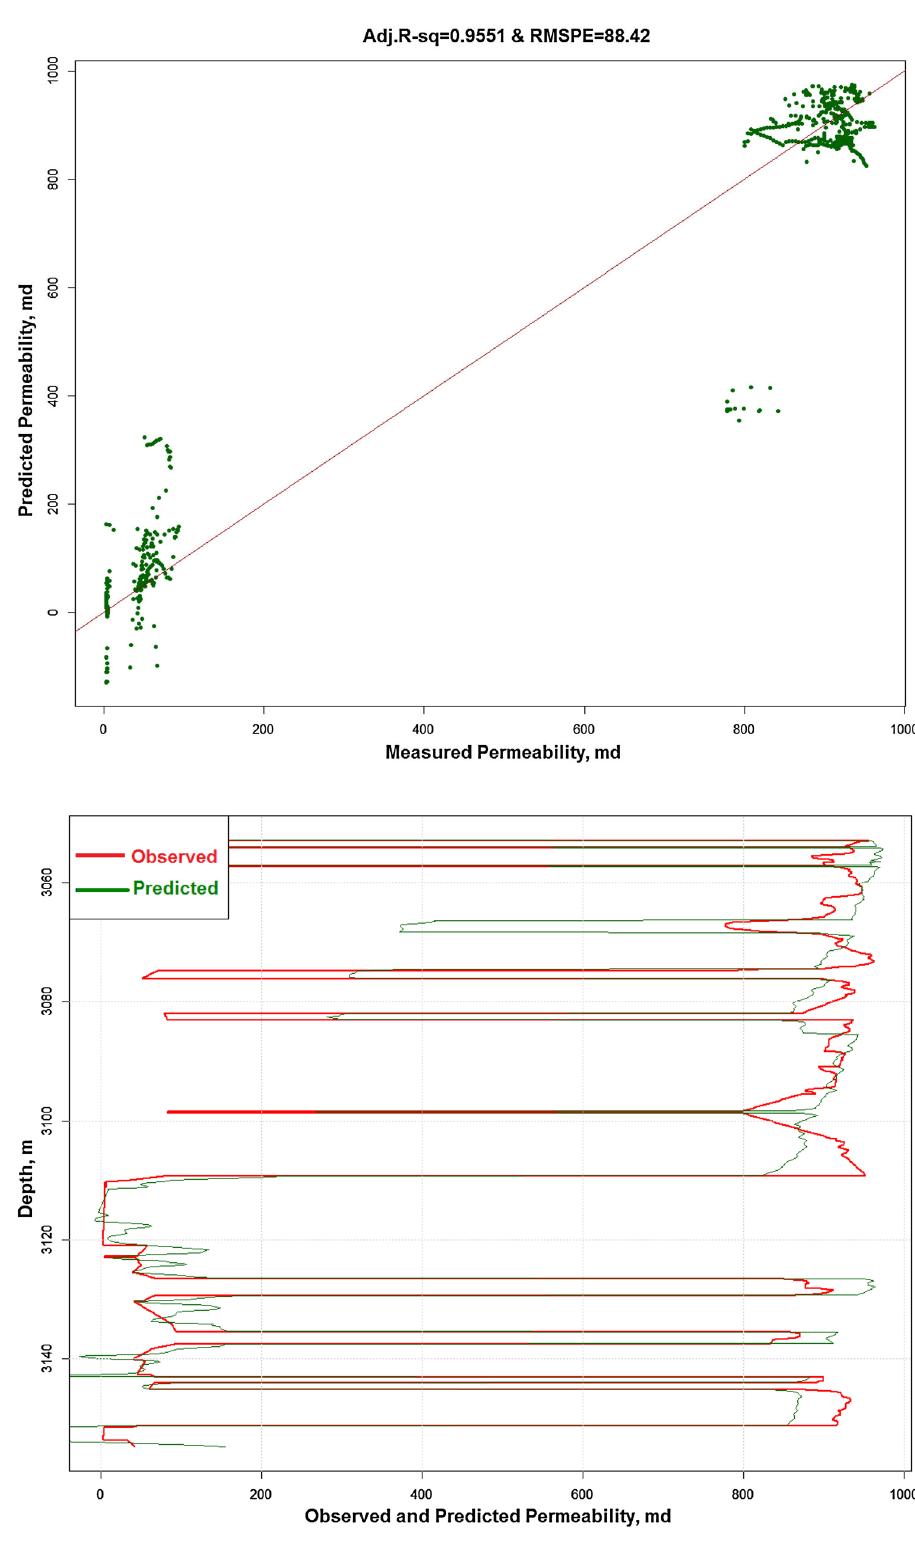
Fig. 9 Scatterplot of predicted and observed core permeability given the testing subset by MLR